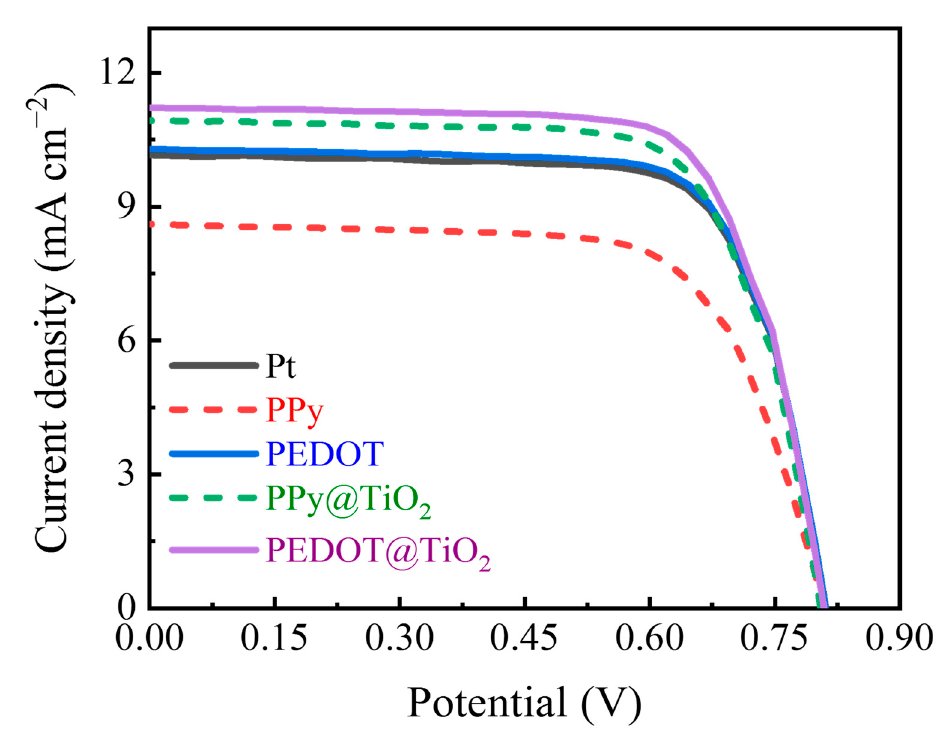
Figure 6. Photocurrent–voltage (J–V) curves of DSSCs with various counter electrodes. Table 3. Photovoltaic parameters of DSSCs with various CEs and [Co(bpy) (cid:2871) ] (cid:2870)(cid:2878)/(cid:2871)(cid:2878) redox couple.